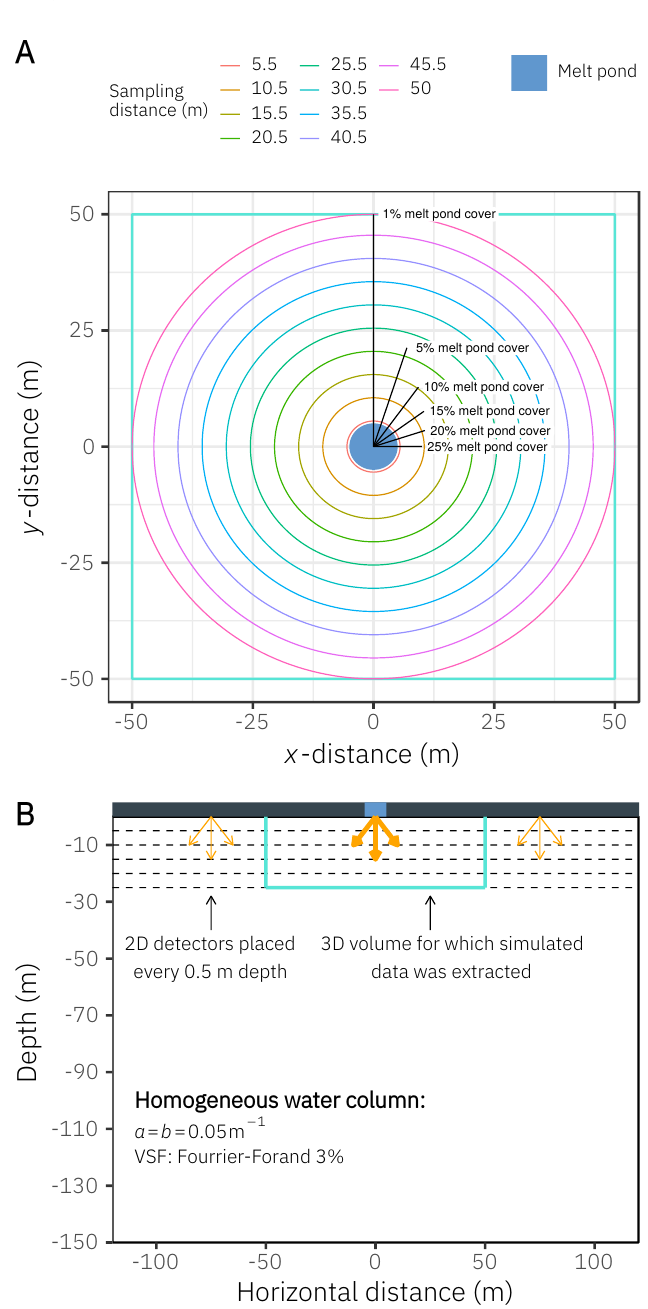
Figure 1. Spatial configuration used for the 3D Monte Carlo numerical simulations. ( A ) Surface view showing the percentage of the total area covered by the melt pond over the areas described by the black lines. For each of these areas, light profiles were averaged (see Figure 7). For visualization purpose, lines of the horizontal sampling distances from the centre of the melt pond have been plotted only at 5 m intervals. ( B ) 2D side view showing the 3D volume for which simulated data were extracted and how photon detectors were placed in the water column. Orange arrows indicate incident light sources.